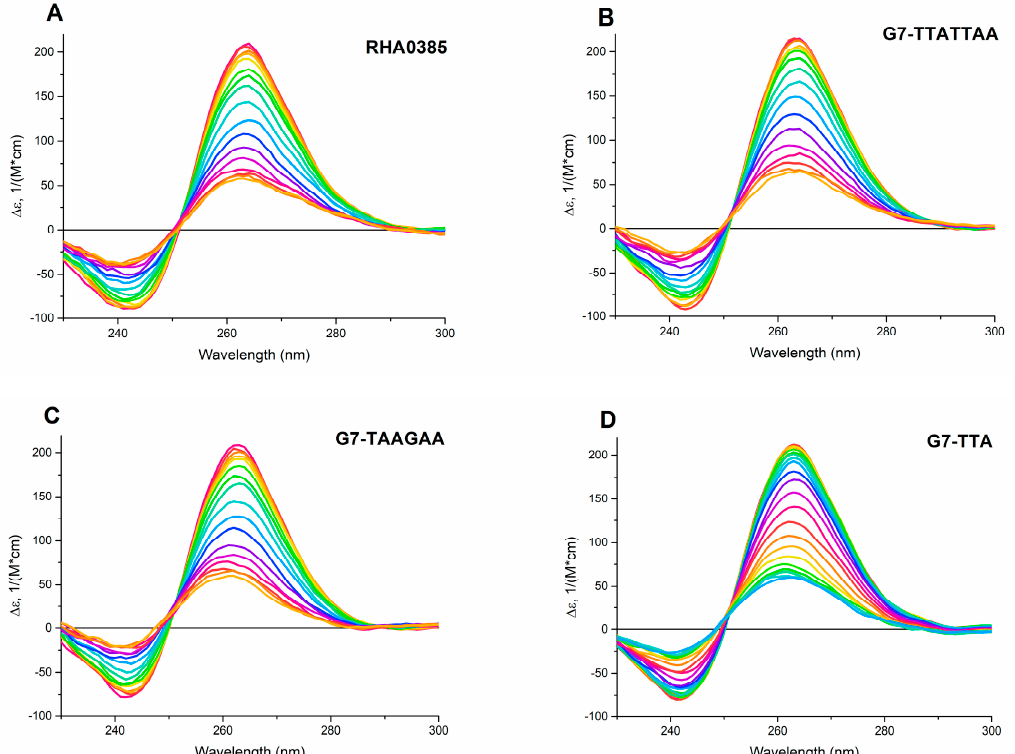
Table 1. Thermodynamic parameters and T m of G-quadruplex aptamers folding. Comparison with parameters of parallel G-quadruplex 11/23 (TGAGGGTTGGGAGGGTGGGTAA) [33] is described